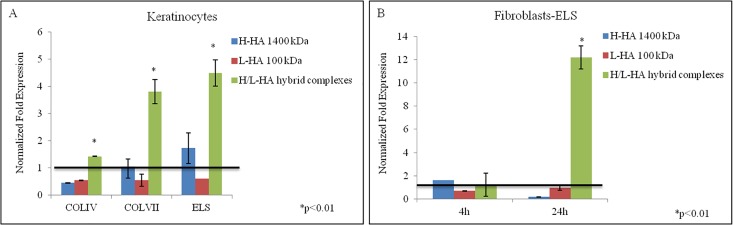
qRT-PCR relative to COLIV, COLVII and ELS expression.Transcriptional analysis relative to COLIVA1 and COLVIIA1 and ELS genes in (A) keratinocytes at 4h and (B-C) fibroblasts, in presence of H-HA, L-HA and H-HA/L-HA complexes 0.16% (w/w) at 4 and 24h. Values are the mean ± SD of three different experiments and are expressed as mRNA normalized fold increase respect to CTR (1). The samples (H-HA/L-HA complexes respect to H-HA) are significantly different in according to Student’s t-test (*p<0.01).